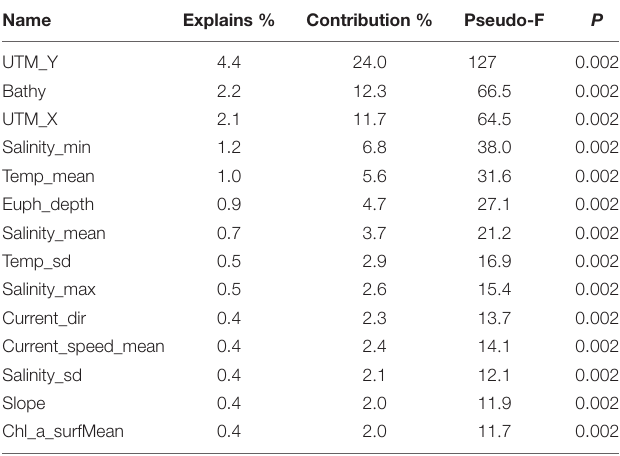
TABLE 3 | Results from forward selection analysis of environmental